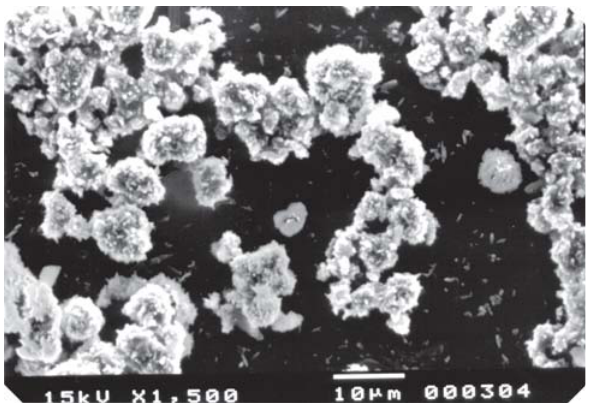
FIGURE 1- Abrasive particles of Colgate dentifrice